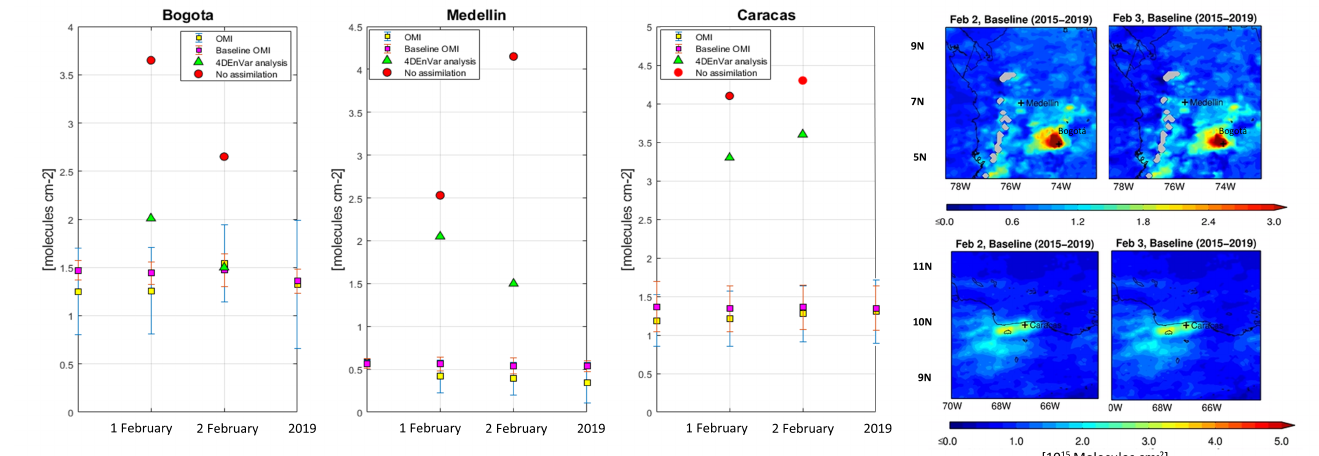
Figure 14. ( Left ), Comparison between the assimilated output and the OMI vertical column density for the February days experiment. ( Right ), Maps showing 15 days of OMI tropospheric NO 2 mean values gridded at a resolution of 0.1 ◦ by 0.1 ◦